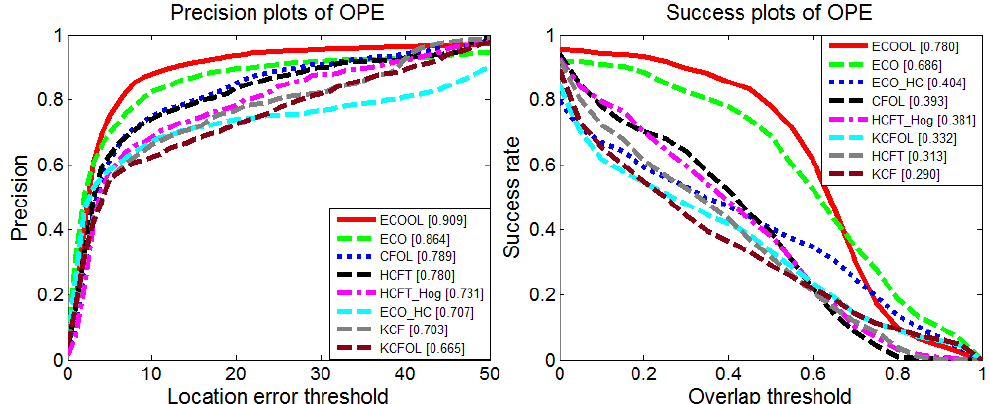
Figure 12. Baseline comparison using different features. ECO, Efficient Convolution Operator; HCFT, Hierarchical Convolutional Features Tracking; KCF, Kernelized Correlation Filter. ECOOL, Efficient Convolution Operator with Online Learning. CFOL, Convolutional Features with Online Learning. KCFOL, Kernelized Correlation Filter with Online Learning.